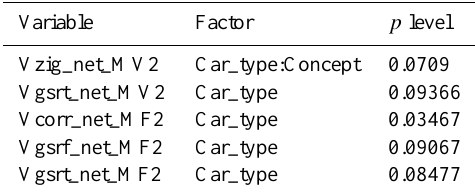
Figure 6. Results of EMG and GSR measures. Table 4. Bio-signals.